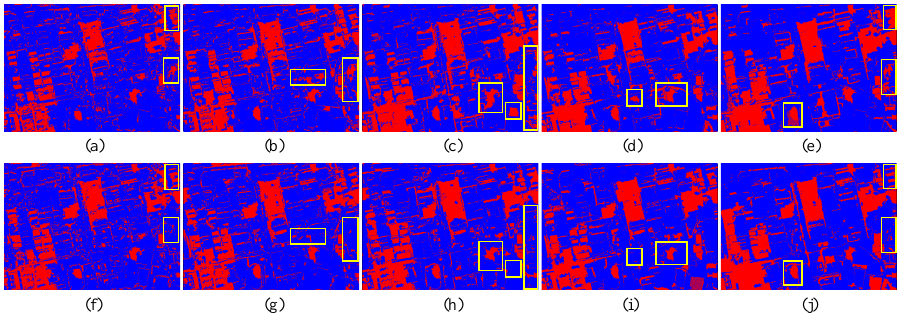
Figure 4. Change detection results of the EL method with one Monte Carlo run, where red denotes change and blue denotes non-change. ( a – e ) are the results with spectral features with the scale from 100–300 in steps of 50; ( f – j ) are the results with multiple features with the scale from 100–300 in steps of